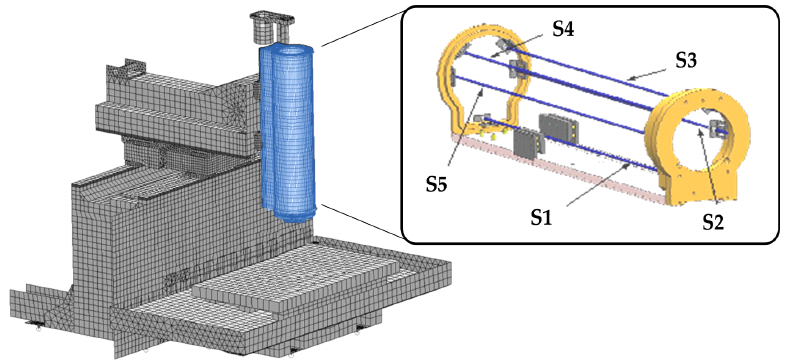
Figure 1. The adaptive structure concept and the sensor locations (internal view).